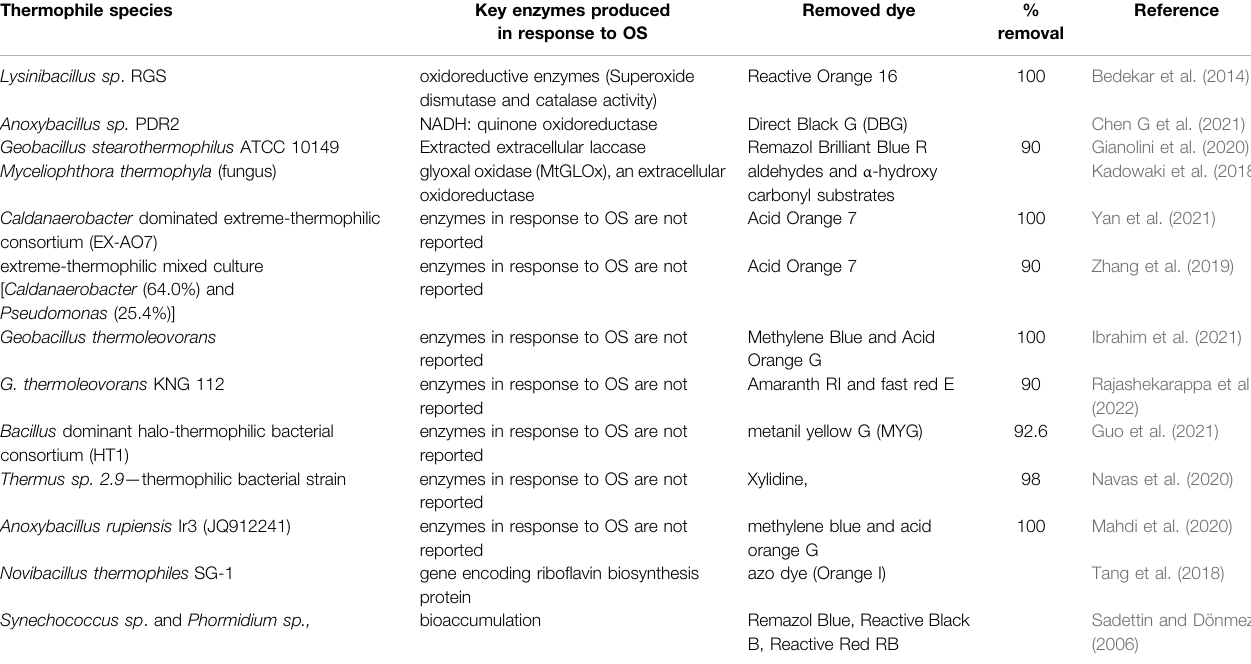
TABLE 2 | Enzymes produced from thermophile species in response to oxidative stress in the degradation process of textile